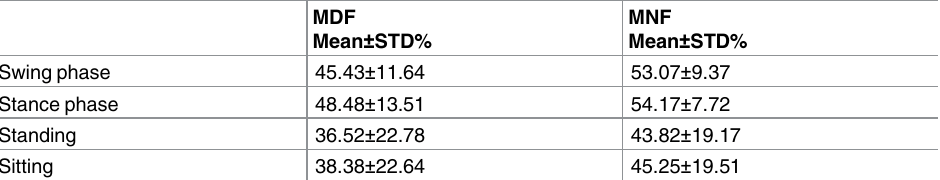
Table 2. The mean and STD for frequency-domain features based on experimental trails from all par- ticipants on the vastus medialis muscle.